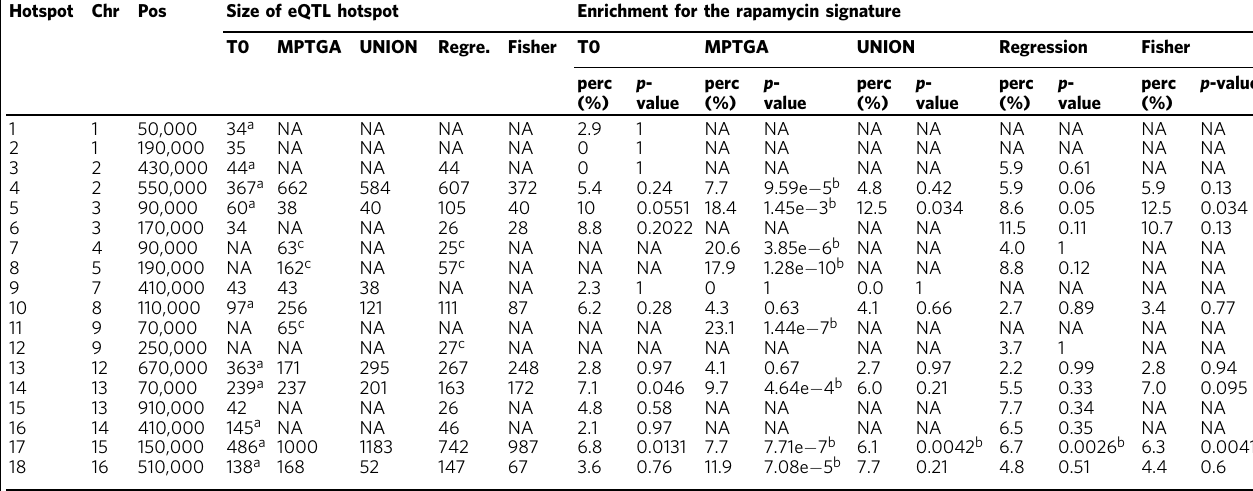
Table 2 Hotspots identi fi ed by different approaches and enrichment analysis of rapamycin response signature Hotspot Chr Pos Size of eQTL